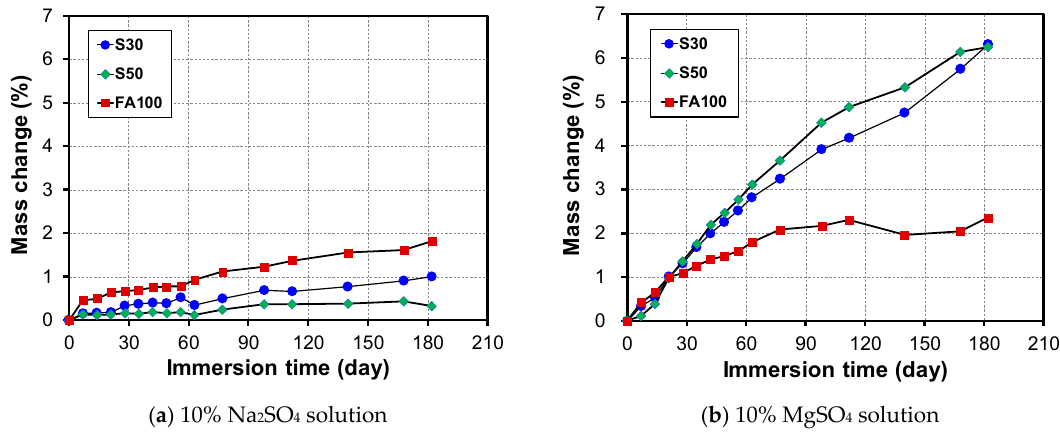
Figure 2. Change in mass depending on GGBFS content, immersed in ( a ) 10% Na 2 SO 4 solution and ( b ) 10% MgSO 4 solution.